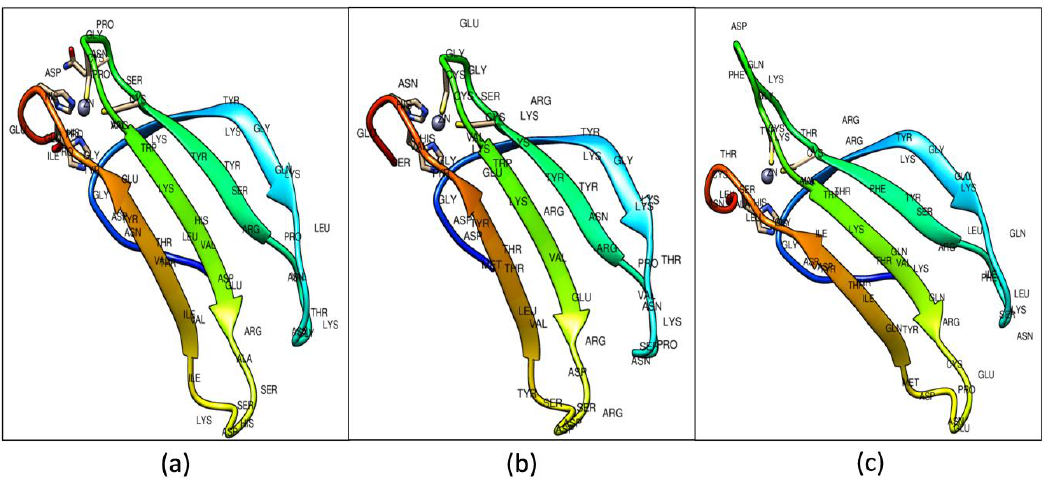
Figure 3. Predicted 3D structure of ( a ) Type I WRKY DBD; ( b ) Type II; and ( c ) Type III WRKY DBDs from pigeonpea. The ligand-binding pockets shown in blue color.